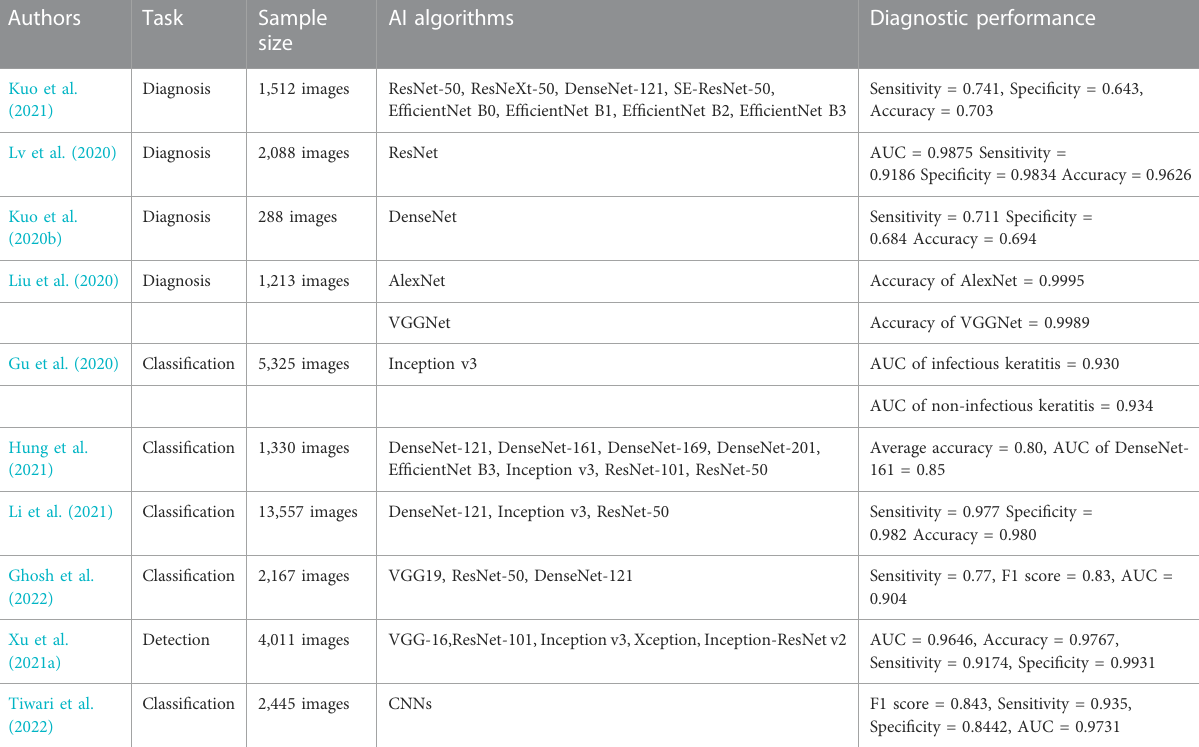
TABLE 1 Summary of application of AI models in